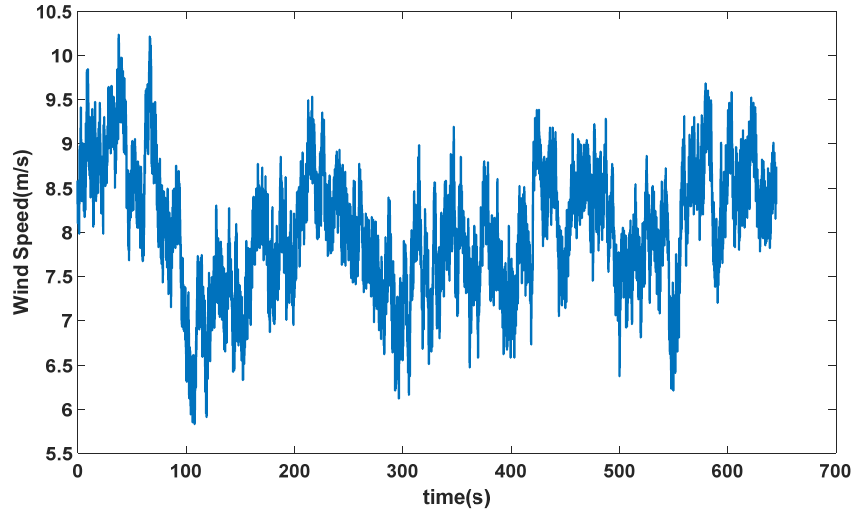
Figure 5. Wind speed at the hub height of the turbine.